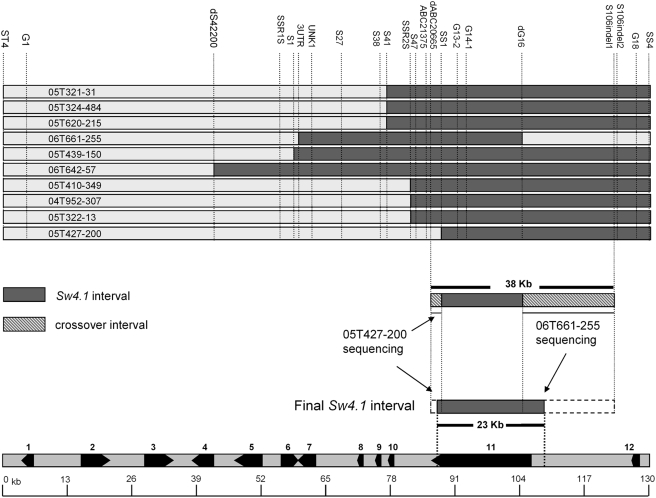
Results from progeny testing of key recombinants to delineate the position of Sw4.1 in BAC.Shaded area indicates where Sw4.1 QTL is assigned in each recombinant based on progeny tests (see Table 1). Cumulative results pinpointed Sw4.1 to 38 kb interval. Sequencing of two key flanking recombinants (05T427-200 and 06T661-255) further delineated Sw4.1 to a 23 kb interval containing single gene in BAC (gene 11, ABC transporter) (bottom).